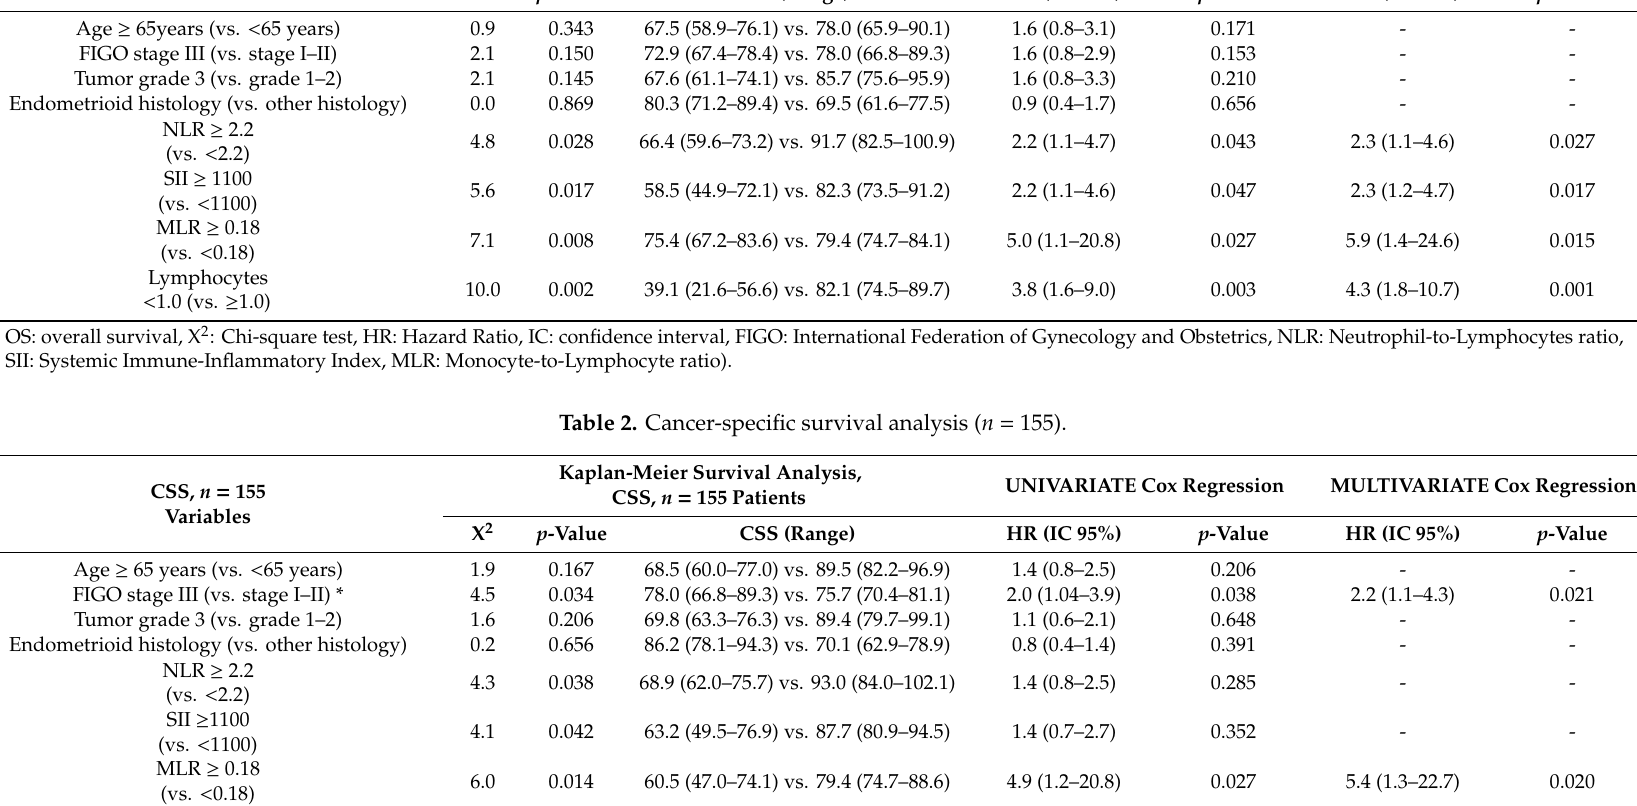
* FIGO stage III in separate Cox multivariate models: HR = 2.4 (IC 95% 1.2–4.7, p = 0.014) for lymphopenia. CSS: cancer-specific survival, X 2 : Chi-square test, HR: Hazard Ratio, IC: confidence interval, FIGO: International Federation of Gynecology and Obstetrics, NLR: Neutrophil-to-Lymphocytes ratio, SII: Systemic Immune-Inflammatory Index, MLR: Monocyte-to-Lymphocyte